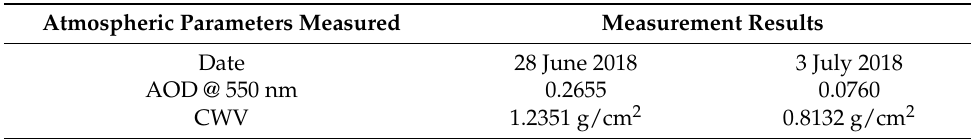
Table 3. Synchronous atmospheric parameters measurements.